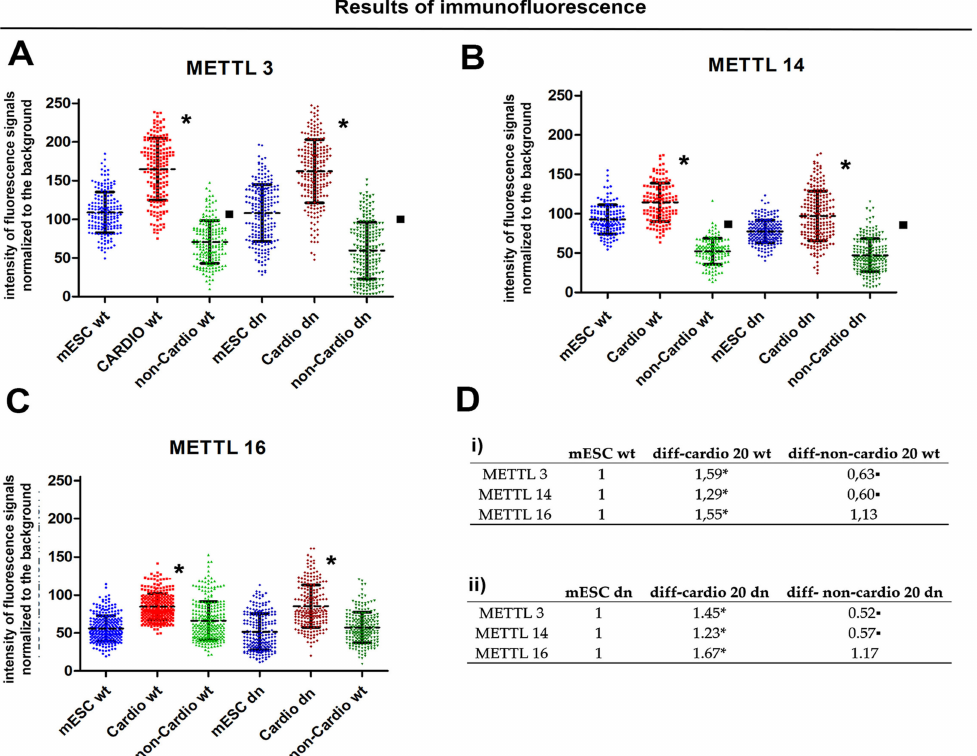
Figure 5. METTL-likeproteinswereanalyzedinHDAC1wtandHDAC1dnmouseESCs. ( A )Fluorescence intensity of ( A ) METTL3, ( B ) METTL14, and ( C ) METTL16 in HDAC1 wt mESCs and HDAC1 dn mESCs. Asterisks (*) show increased levels of proteins studied during cell di ff erentiation and compared with control non-di ff erentiated cells. Squares ( (cid:4) ) show decreased levels of proteins. As statistically significant di ff erences, marked by asterisk or squares, are considered results di ff erent from control value (at p ≤ 0.05). The Student’s t-test was used for statistical analysis. Experiments were repeated trice (panels ( A – C )); 200–300 cells were analyzed for each experimental event. ( D ) The table shows numerical values (fold changes) linked to panels ( A – C ). Fold-change is an estimation of the data ratio (a ratio of the two